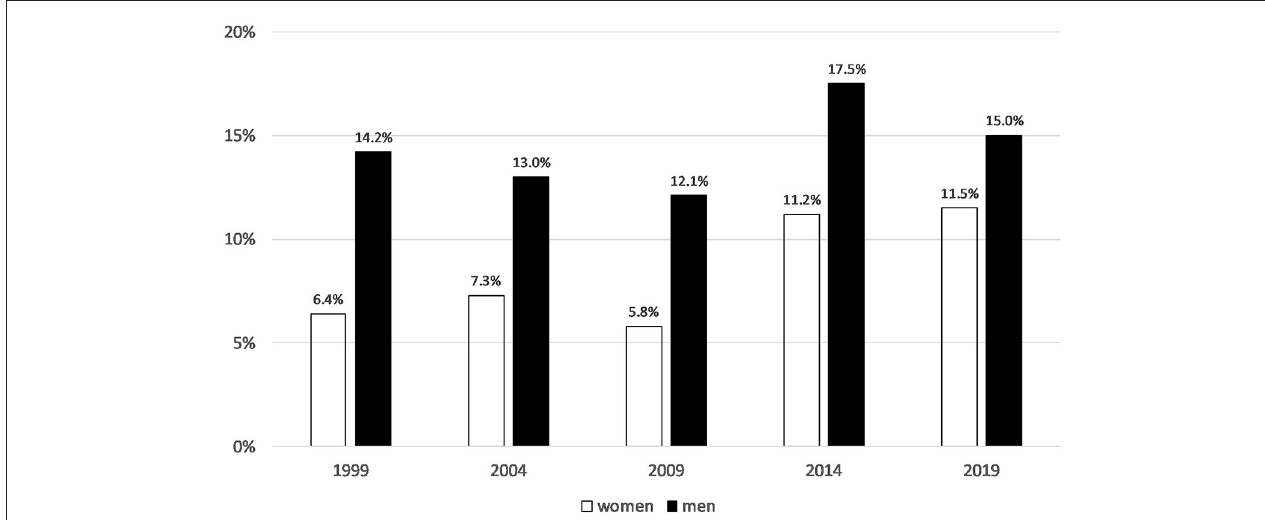
FIGURE 5 | Population share of people volunteering in sport and physical activity (1999 N = 14,155, 2004 N = 14,217, 2009 N = 19,048, 2014 N = 27,350, 2019 N = 26,568). German Survey on Volunteering (FWS).